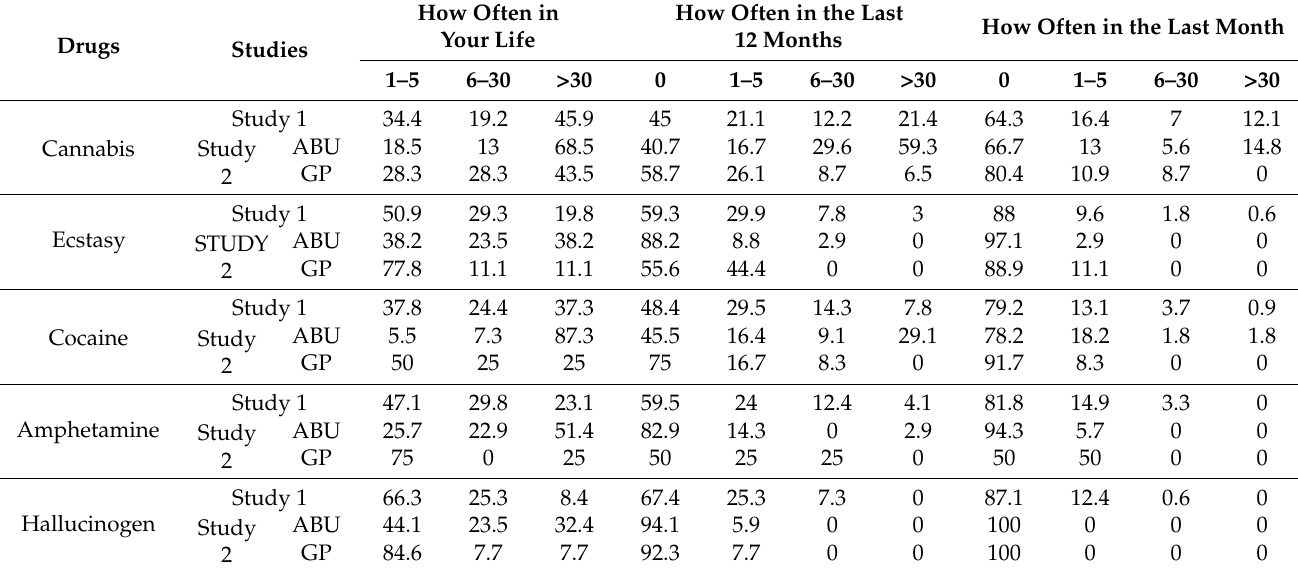
Table 3. Levels of drug use in one’s life, in the last 12 months and in the last month.